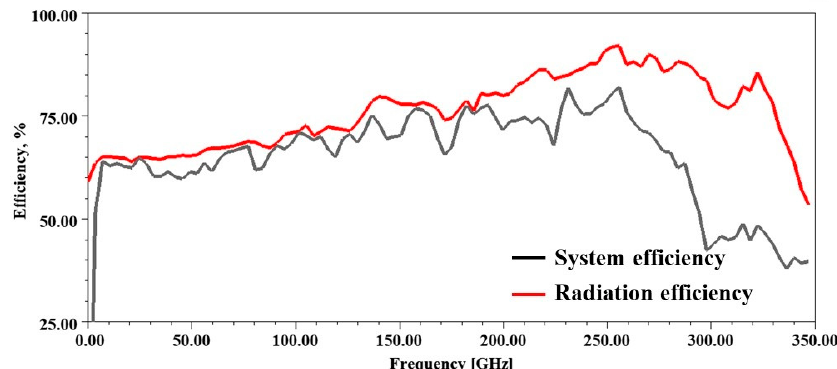
Figure 10. Efficiency characteristics of the suggested antenna.